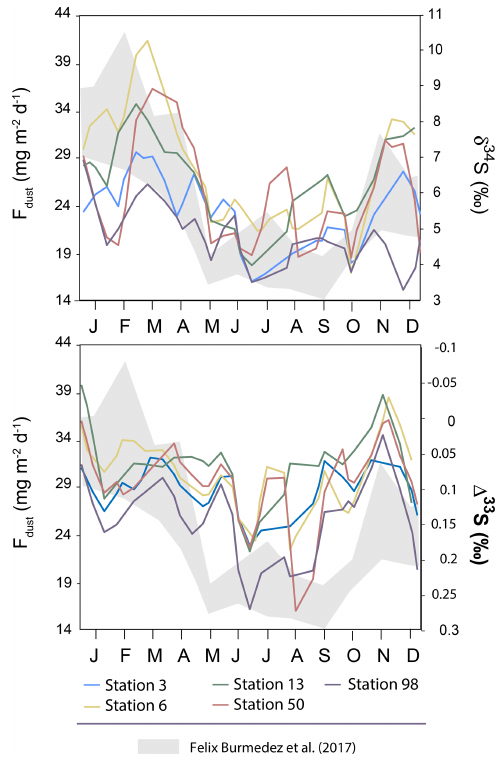
Figure 5. Variations of the mean δ 34 S and (cid:49) 33 S-values over time in sulfate aerosols collected in Montreal. The grey band represents the seasonality of the dust deposition rate determined by Félix- Bermúdez et al.